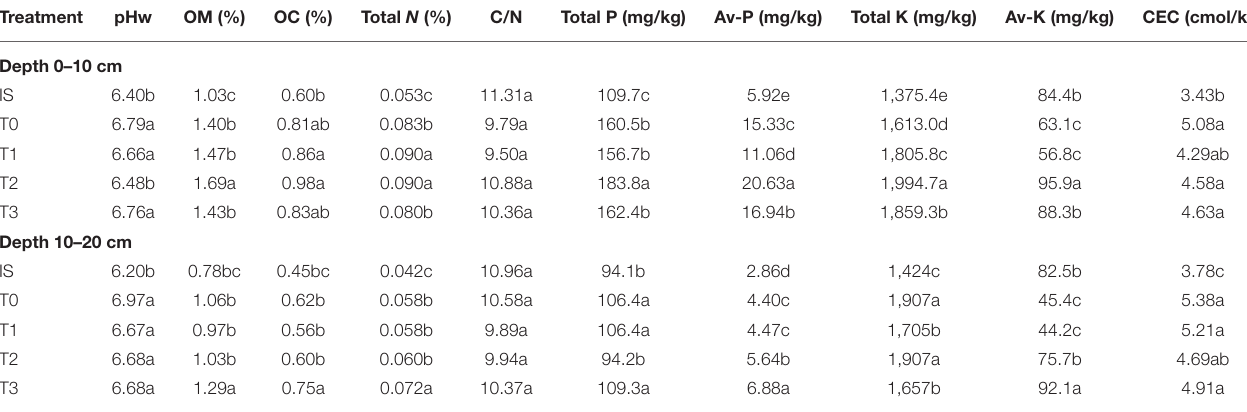
TABLE 2 | Soil chemical characteristics at different depths. Treatment